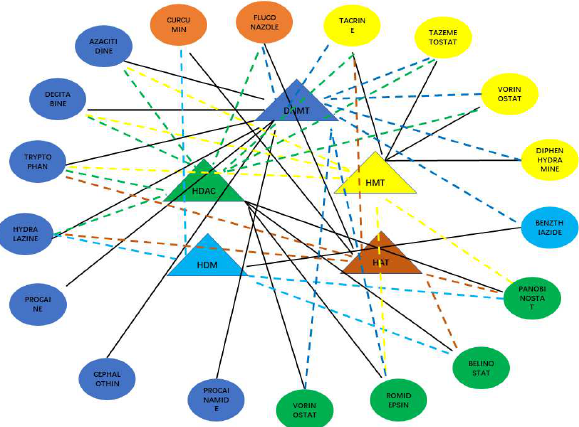
Figure 6. Polypharmacological analysis of 18 known drugs with four epigenetic objects. Different colors represent different epigenetic objects: Blue: DNMT, orange: HAT, yellow: HMT, light blue: HAT, green: HDAC. Sig indicates statistical significance in the Hypergeometric test for all targets in each object. Black lines indicate proven targeting interactions.